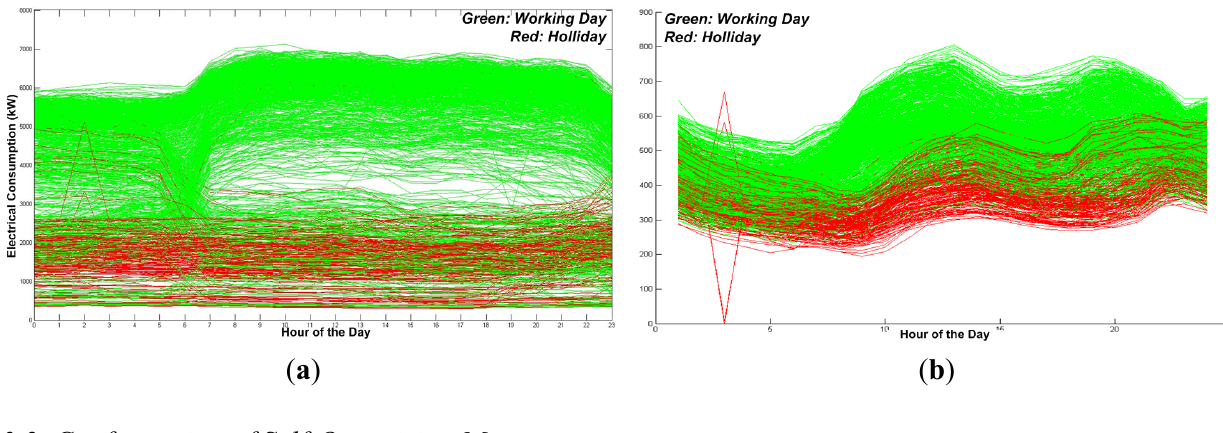
Figure 3. Load curves of ( a ) industrial park “Las Casas”; ( b ) entire city of Soria. Green curves represent working days and red curves represent not-working days (Sundays and